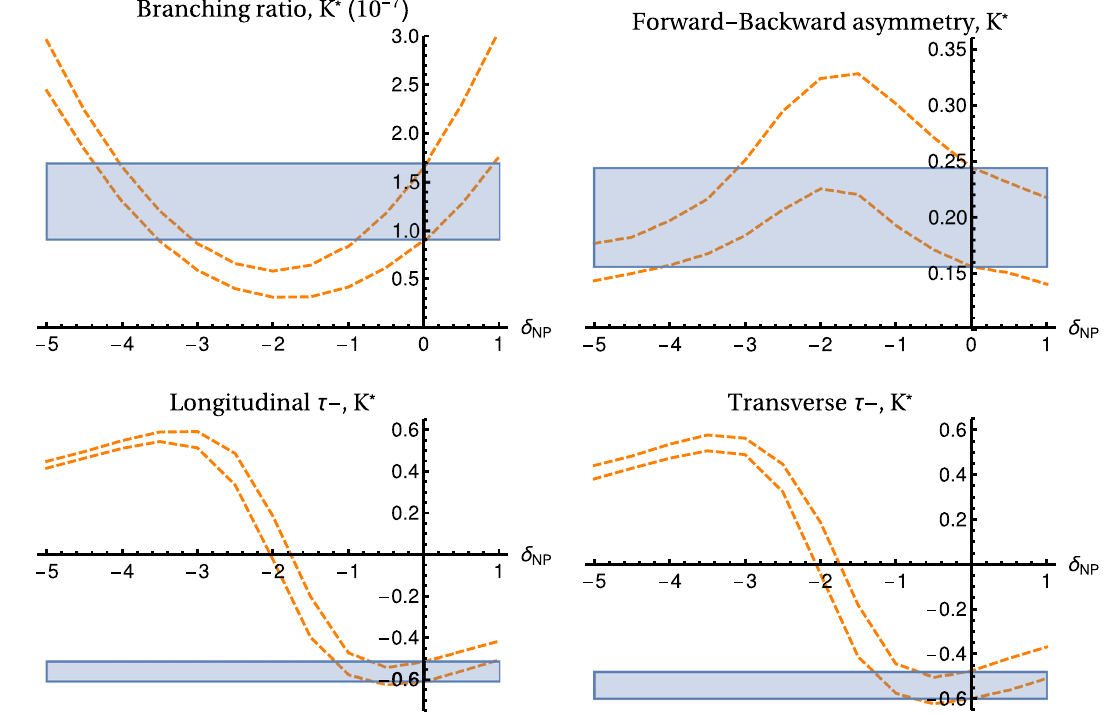
= − δ C = − C (cid:8) ≡ δ 10 NP , whose values are given in the horizontal axes. See Fig. 4 9 10